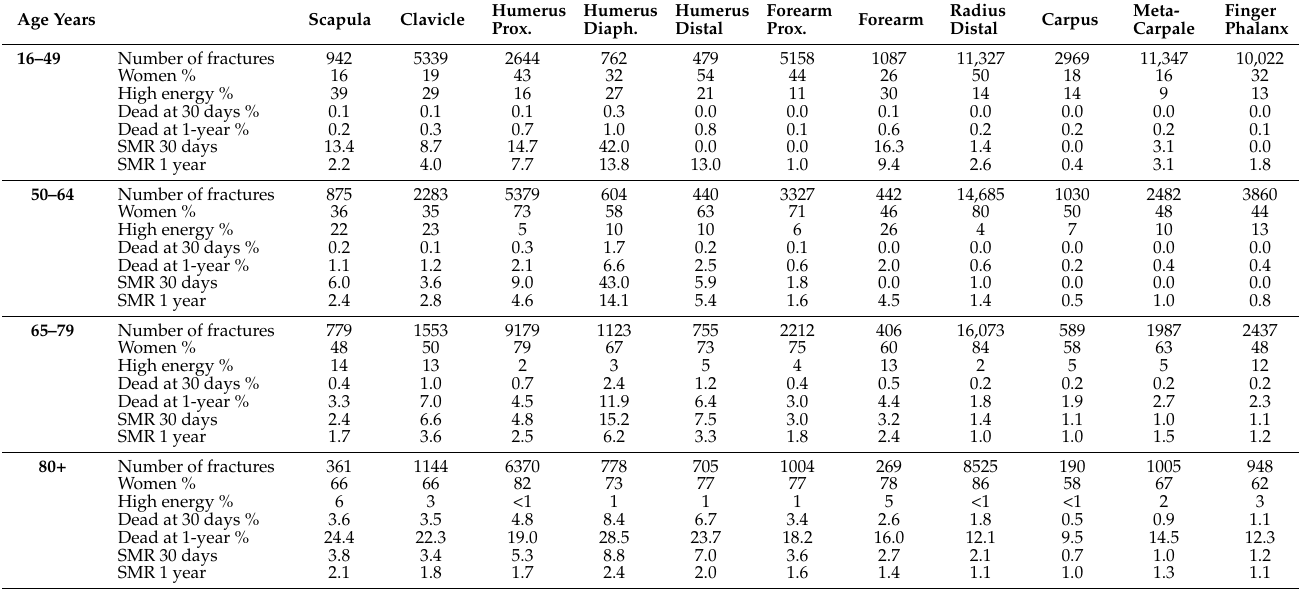
Table 4. Number of fractures, proportion of women (% total) and high-energy trauma (% total), mortality rate per time point after fracture, and standardized mortality ratios (SMR) per time point after fracture for upper extremity injuries by age